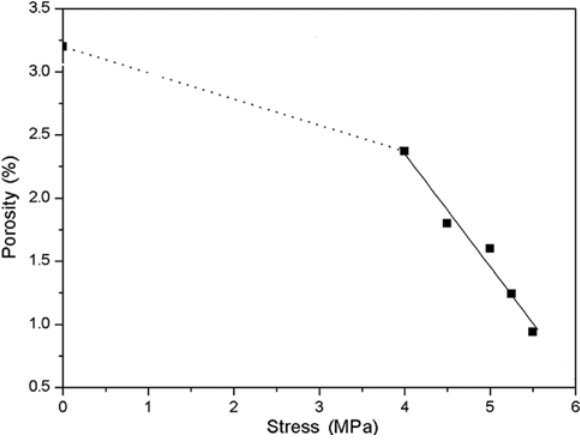
Figure 6: Decrease of porosity with applied stress.